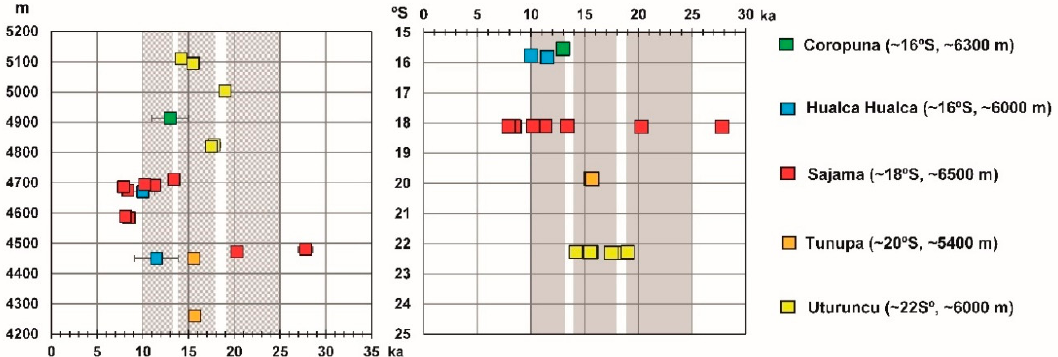
Figure 14. Ages from polished bedrocks in the Arid Tropical Andes. ( Left ): glacial ages vs. altitude. ( Right ): glacial ages vs. latitude. Gray areas: chronology of lake transgressions on the Bolivian Altiplano [10]. The works that must be cited are the same as in Figure 13.